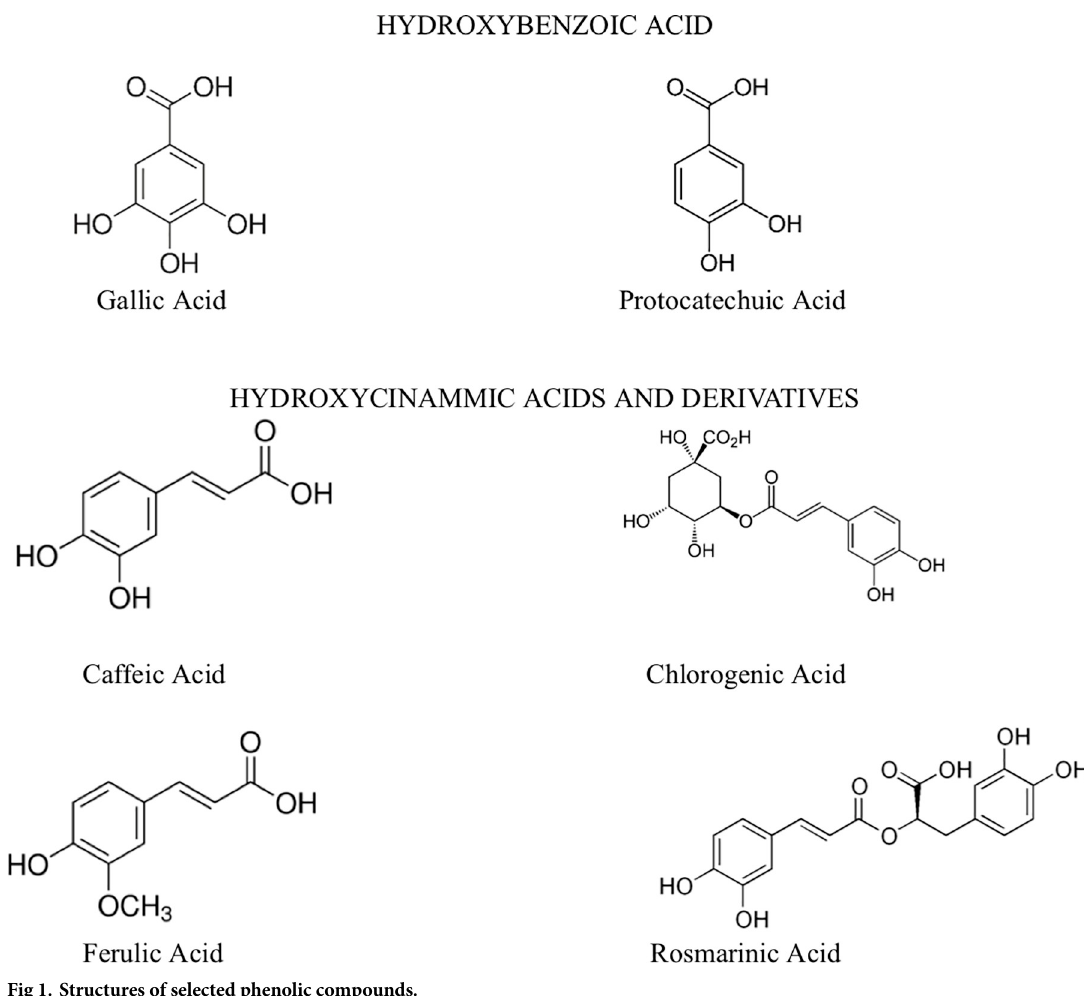
Fig 1. Structures of selected phenolic